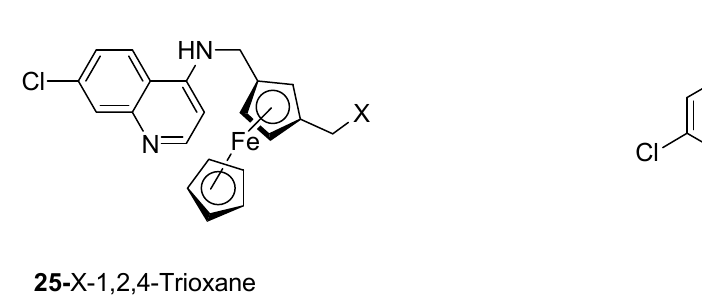
Figure 4. Quinoline-ferrocene hybrid compounds.